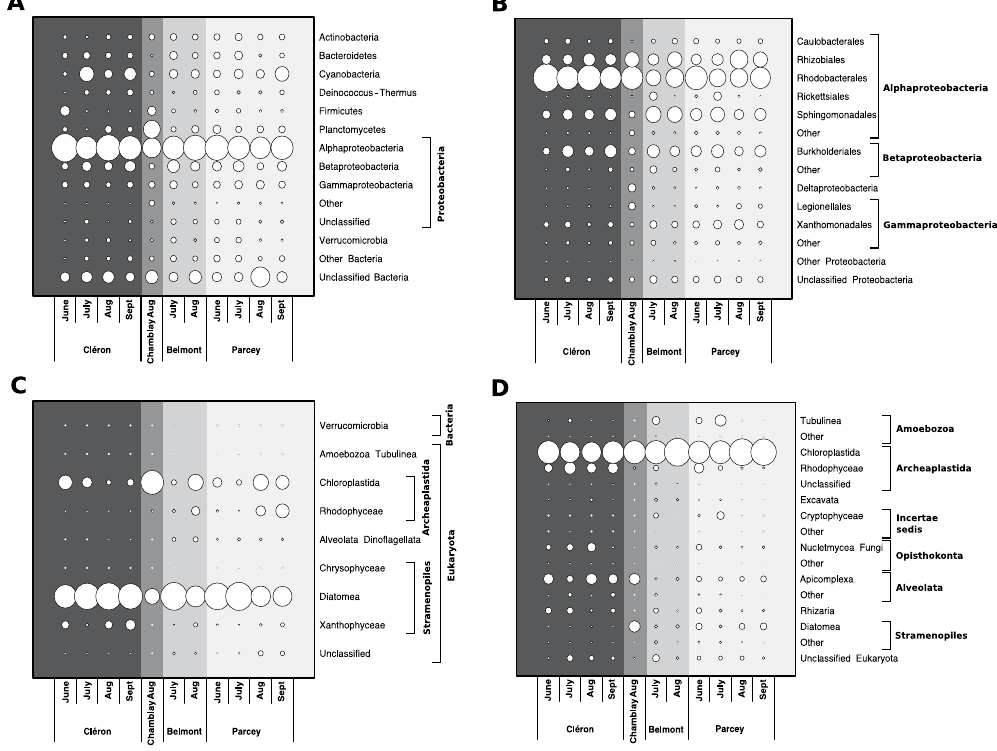
Figure 4. Spatio-temporal variation in the composition of the bacterial ( A ), proteobacterial ( B ), chloroplast ( C ), and microeukaryotic ( D ) communities based on 16S ( A – C ) and 18S ( D ) rRNA gene sequences. Circles represent the mean proportions of microbial sequences in the three replicates for each sampling site and date. Chloroplast 16S rRNA gene sequences were classified by BLAST on NCBI. Abbreviations: Aug, August; Sept,